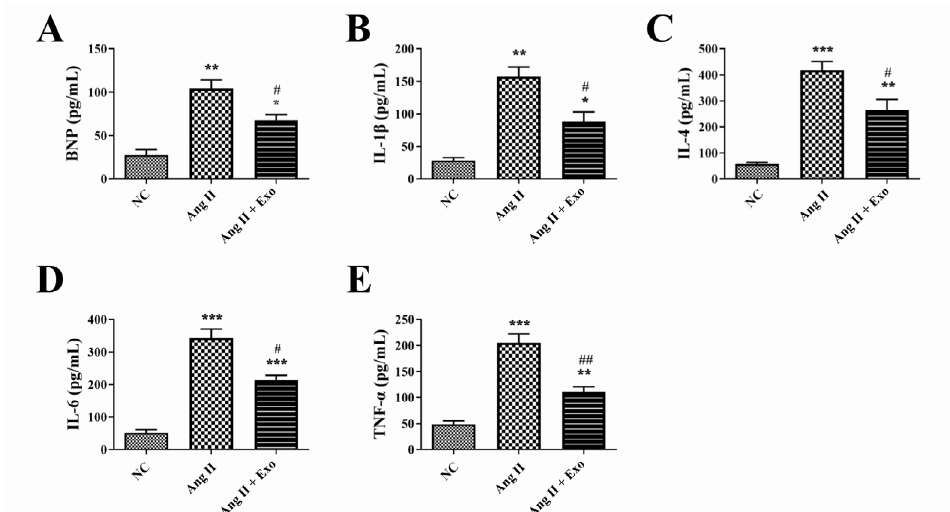
Figure 3 – Effect of MSCs-exosomes on the inflammatory damage in hypertrophic cardiomyocytes. A-E. Levels of brain natriuretic peptide (BNP), interleukin (IL)-1β, IL-4, IL-6, and tumor necrosis factor (TNF)-α in H9c2 cells after treatment with Ang II or/and MSCs-exosomes. * P < 0.05,